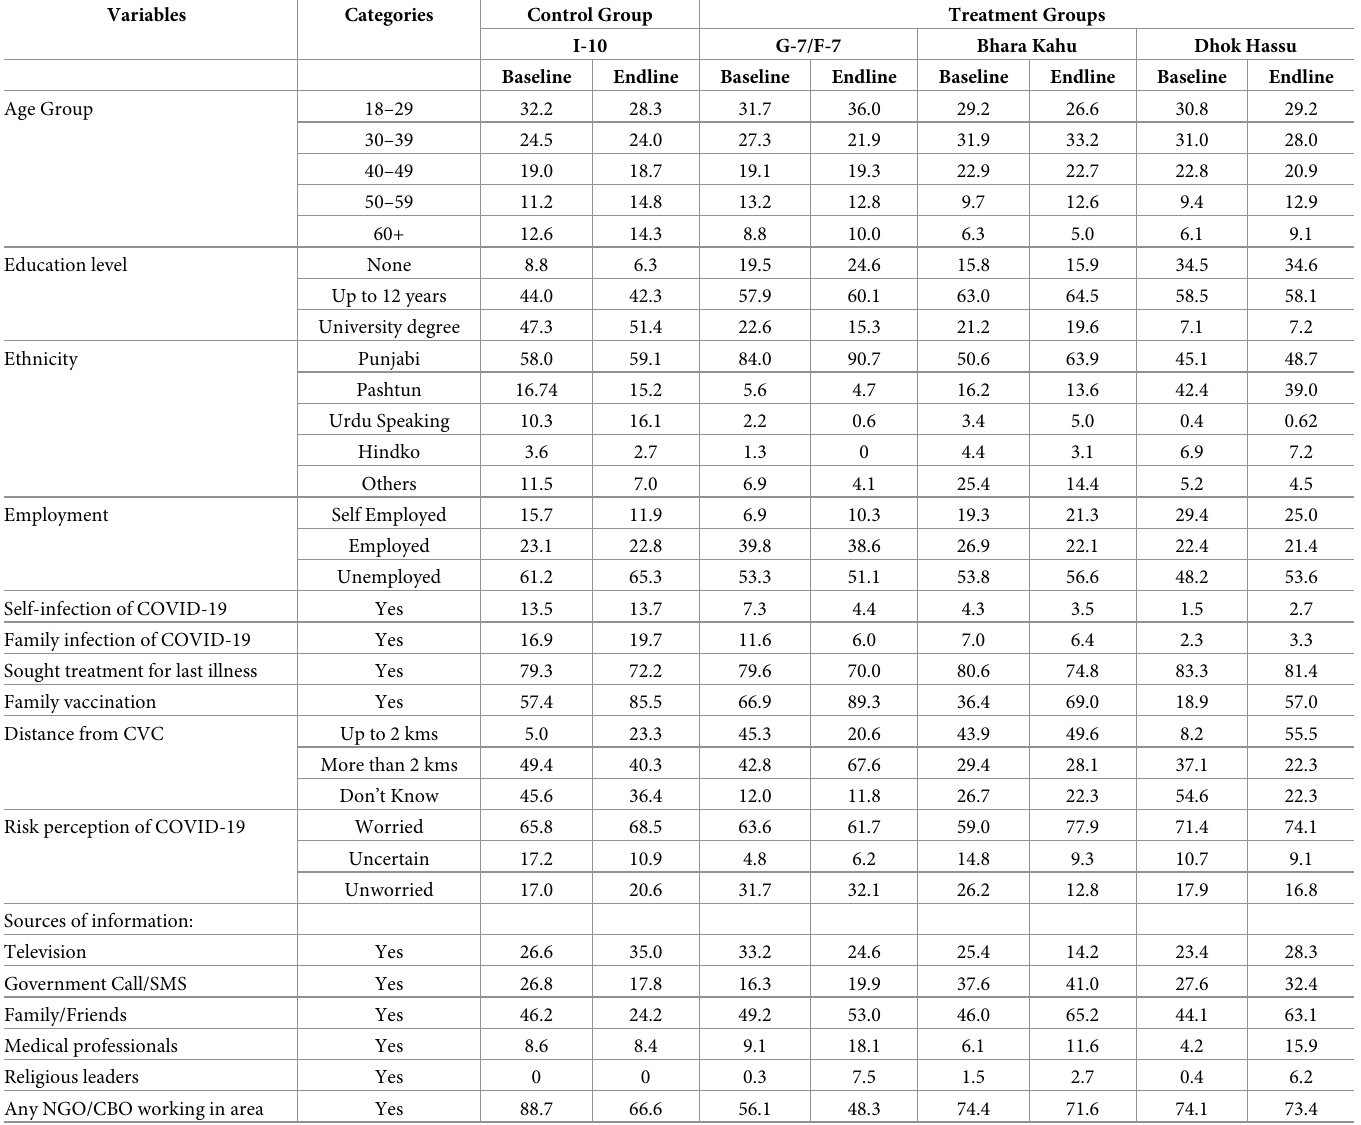
Table 2. Descriptive baseline characteristics in percentages across